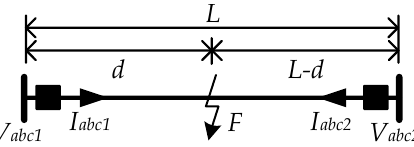
Figure 6. Simplified line model for the Girgis et al. [52]